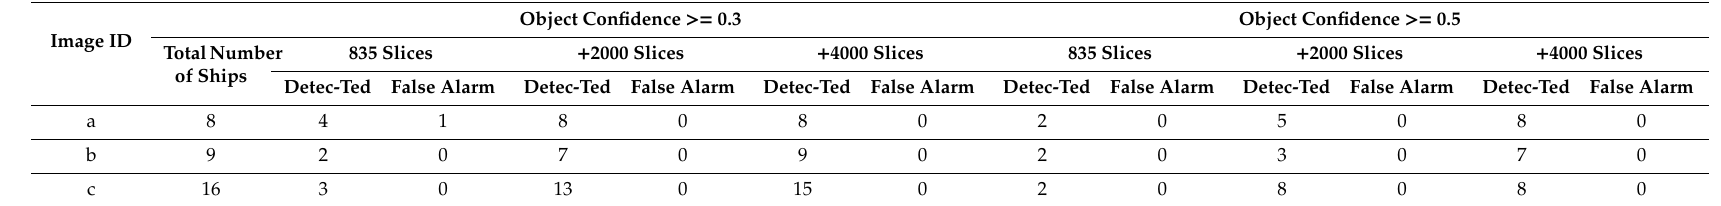
Table 4. Statistics of Yolo v3 detection results.